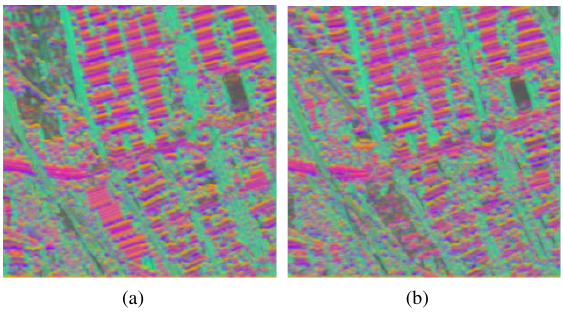
Figure 2: SIFT feature space for VHR images. (a)SIFT feature for Fig. 1(a). (b) SIFT feature for Fig. 1(b).